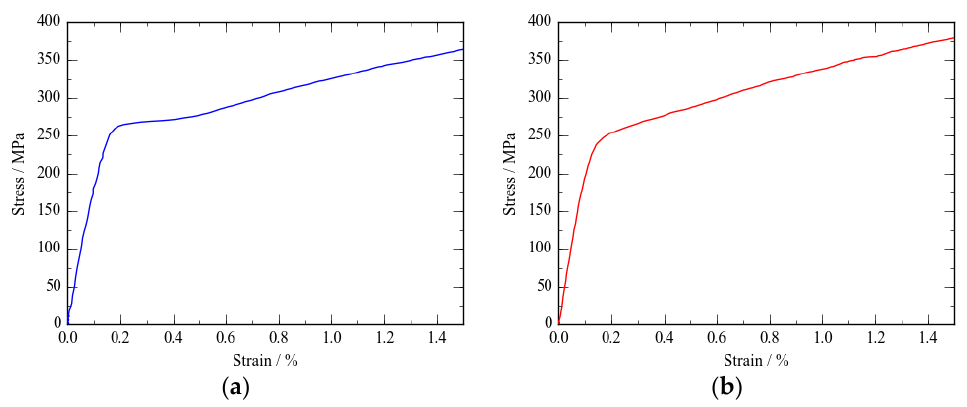
Figure 16. Stress – strain relationship in 0° and 90° directions. ( a ) Stress-strain relationship in 0° direction; ( b ) stress – strain relationship in 90° direction.